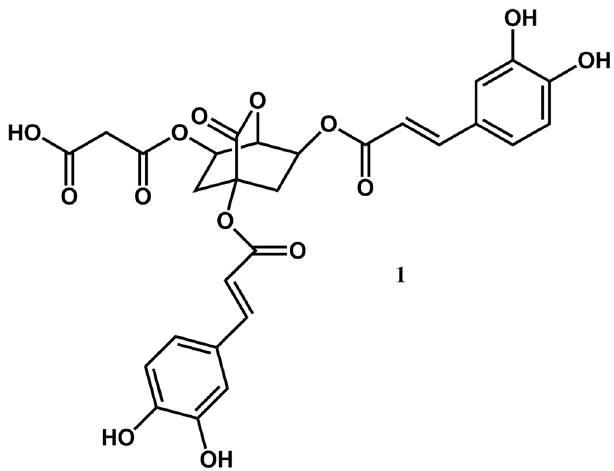
Figure 1. Structure of the previously undescribed compound 1,3-dicaffeoyl-5-malonyl-δ-quinide ( 1 ) isolated from Anthriscus cerefolium . Structure was drawn in ChemDraw Professional 18.0. https:// www. alfas oft. com/ no/ produ kter/ lab/ chemd raw.